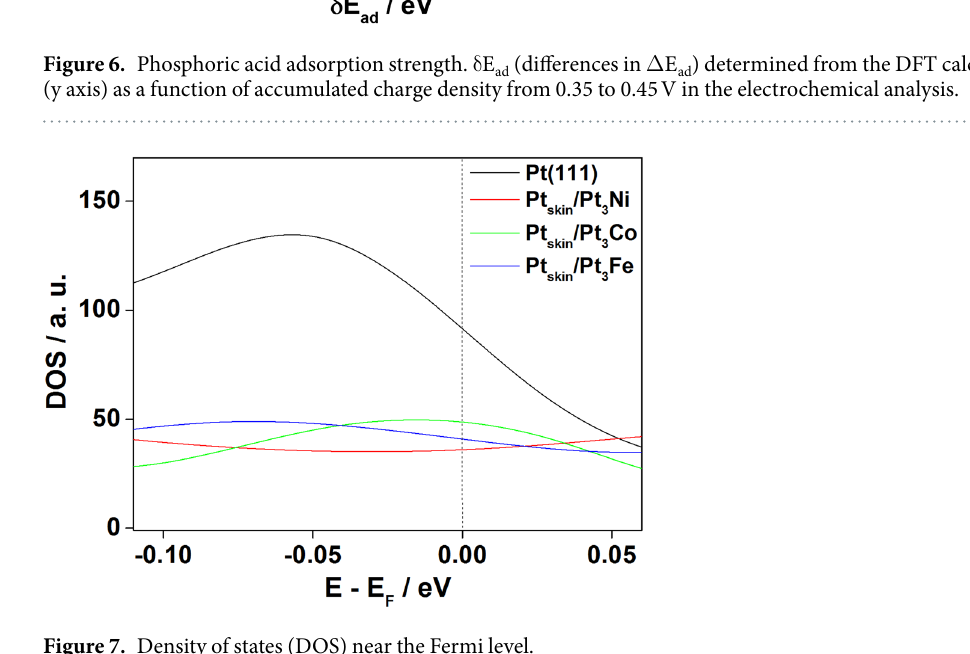
Figure 7. Density of states (DOS) near the Fermi